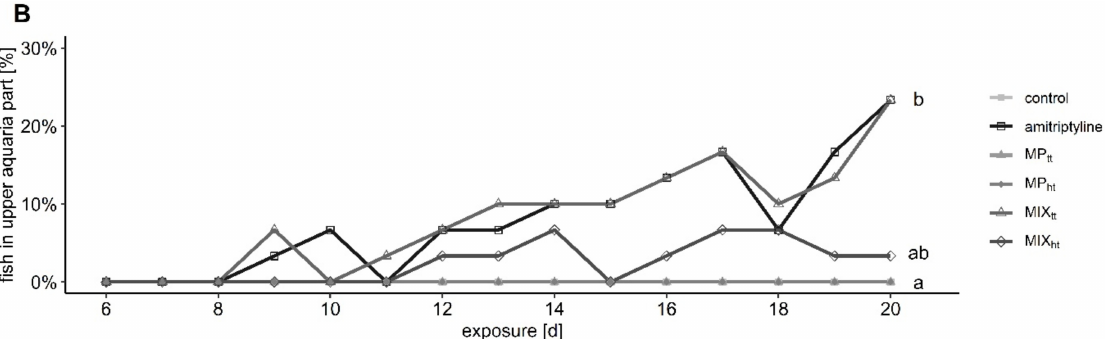
Figure 2. Percentage of fish present in the upper half of the aquaria during the exposure to different amitriptyline concentrations in the first experiment ( A ) and the second experiment ( B ) to amitriptyline or 10 4 particles/L PS MP (MP tt ), 10 5 particles/L PS MP (MP ht ) or the mixtures amitriptyline + 10 4 particles/L (MIX tt ), and amitriptyline + 10 5 particles/L (MIX ht ). 2 ( A ): Significant differences towards the control group are indicated with an asterisk. 2 ( B ): Significant differences between the treatment groups are displayed with different letters. Further statistical information is provided in the Supplementary Table